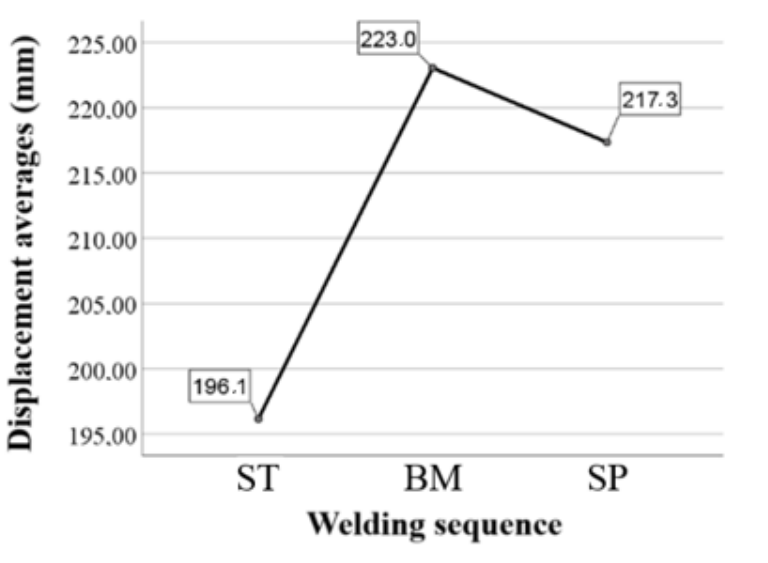
Figure 12. Graph of the displacement averages of ST, BM, and SP sequences.